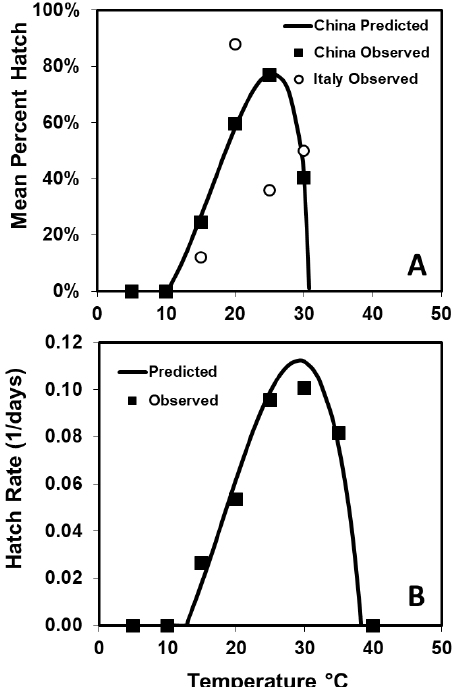
Figure 4. Relationships between temperature and mean percentage egg hatch ( A ) and mean hatch rate (1/d) ( B ) for A. chinensis . In graph A, observed points are solid squares (Chinese) and open circles (Italian), and the predicted line is only for the Chinese population. Results are pooled across populations ingraph B (solid squares are mean observed points).